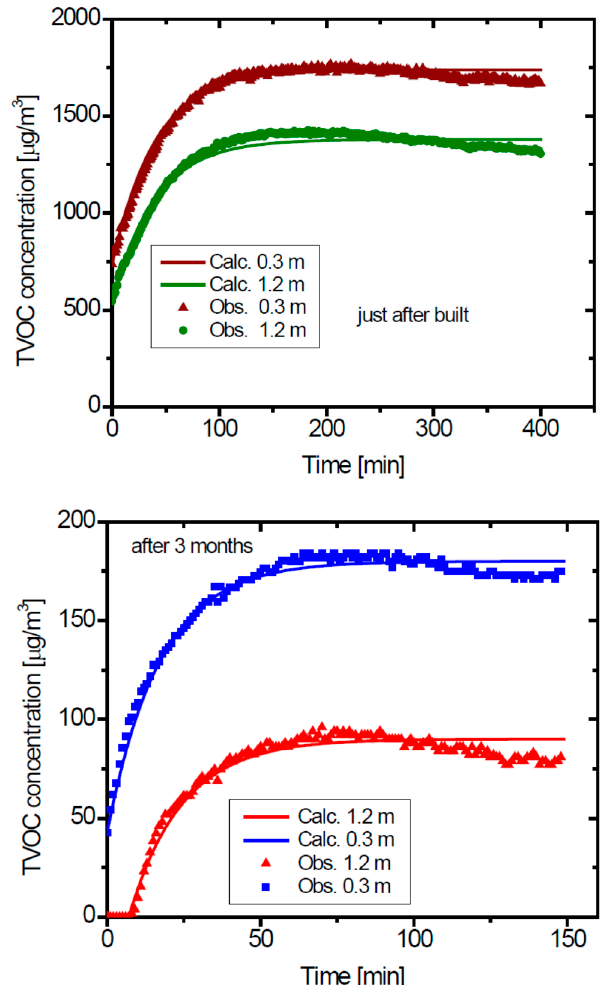
Figure 5. Curve fitted, using Equation (1), to the temporally changing TVOC concentrations measured just after completion.